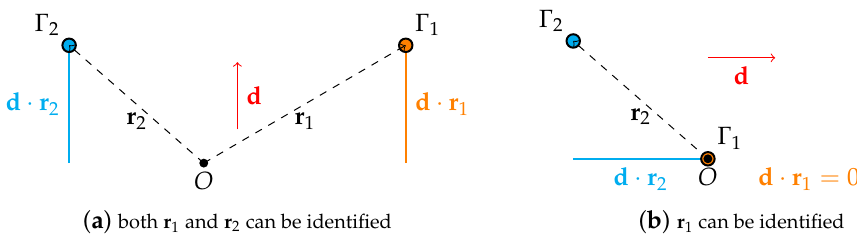
Figure 2. (Remark 3) Illustration of identifiable locations through the map of F MDSM ( x , k 1 , k F , F )